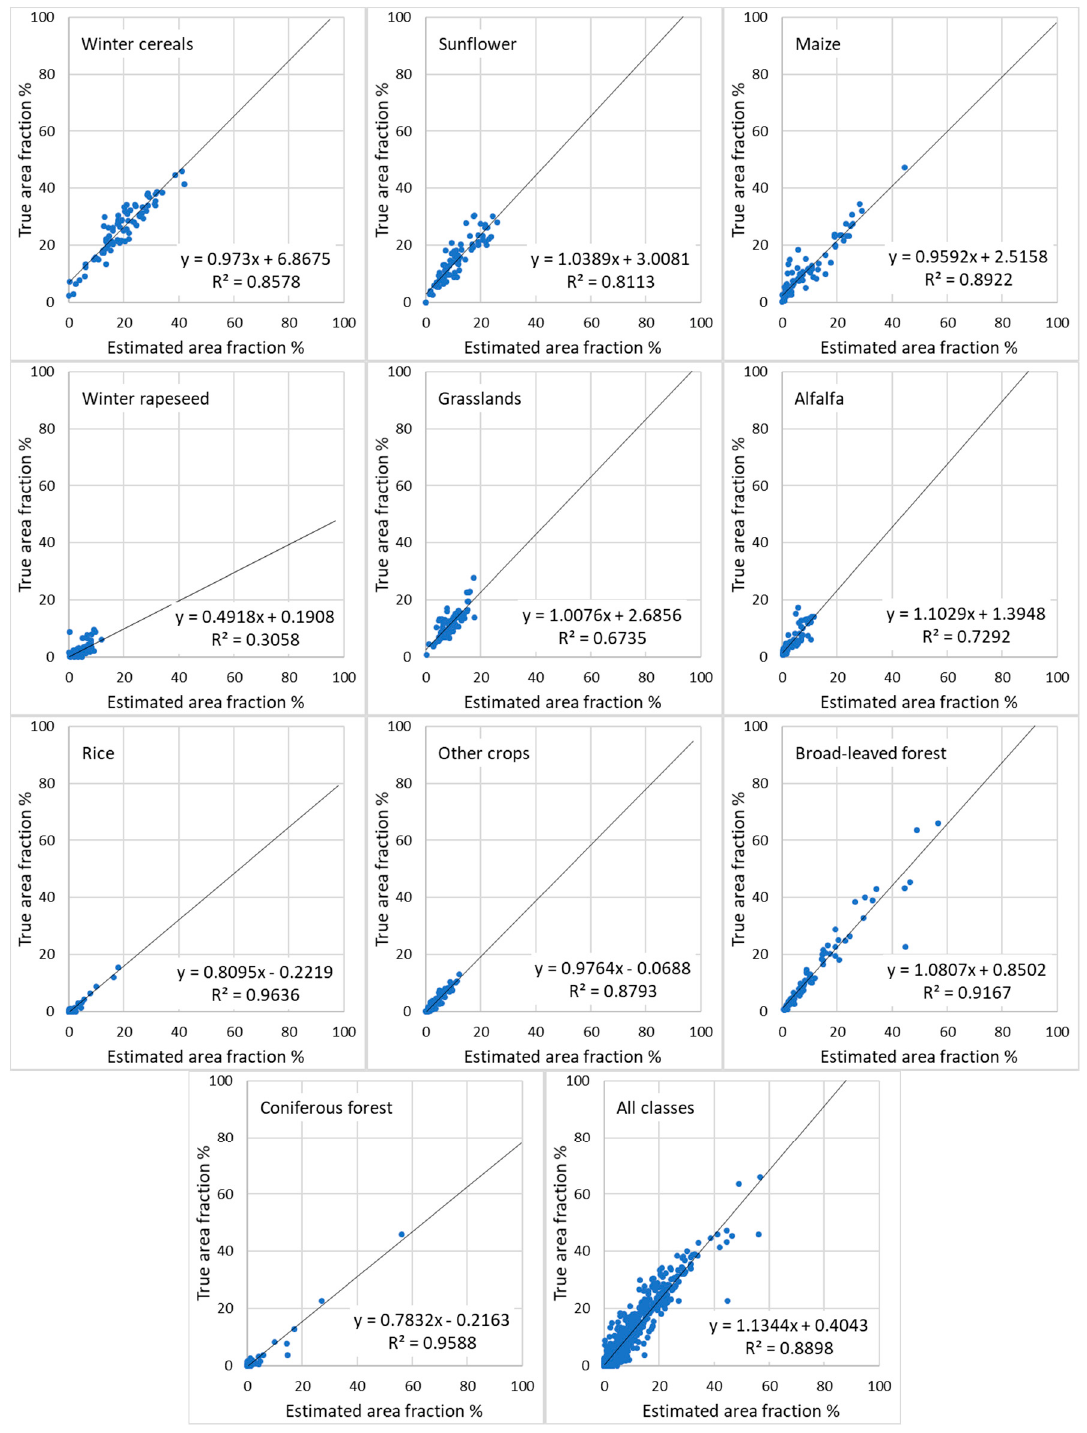
Figure 8. Scatterplots showing the correspondence between true and support vector regression (SVR) estimated area fractions at regional level. The dots represent the averages for the artificial 10 × 10 km² regions as depicted in Figure 1. N = 80, except for the scatterplot for “All classes”, where N = 800.